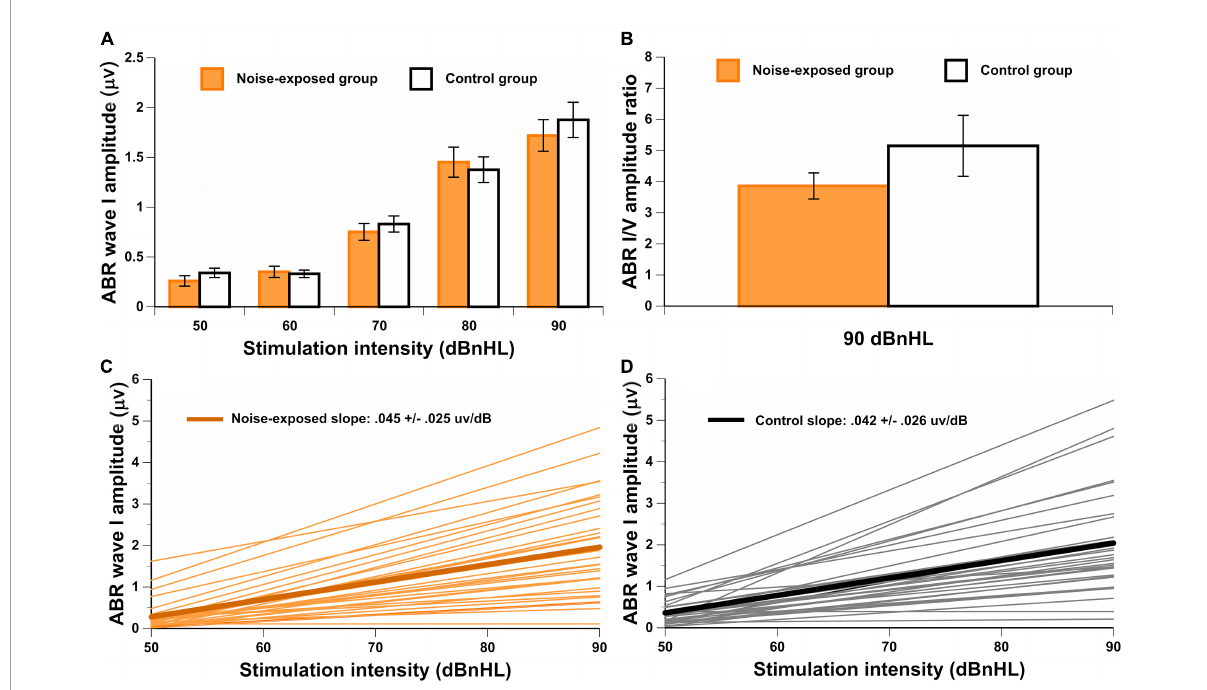
FIGURE4 (A) ABR wave I amplitude for both groups at each stimuli level. In (B) , the wave I/V amplitude ratio for both groups at 90 dBnHL. The group mean and individual results for the ABR AMP-I Slope are also illustrated in (C,D) for noise-exposed and control groups. There are no significant differences between